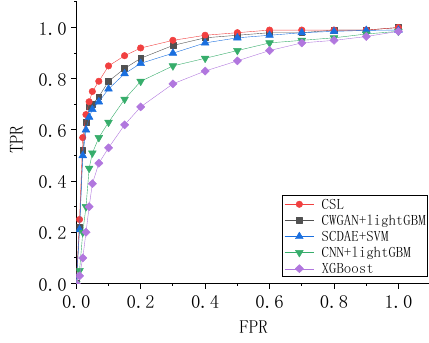
Figure 9. Comparison of ROC curves of each model.